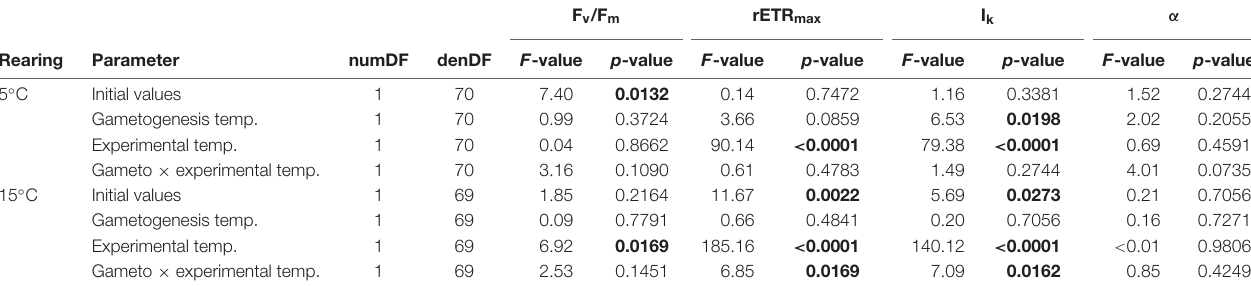
FIGURE 5 | Reaction norms of fluorometric parameters averaged over all five genetic lines of juvenile Laminaria digitata sporophytes in experiment 2. Primary x-axis: experimental temperature, secondary x-axis: rearing temperature, symbol colors: gametogenesis temperature. All plots show values obtained at the end of the 12-day experiment. (A) Optimum quantum yield F v /F m . (B) Maximum relative electron transport rate rETR max . (C) Saturation irradiance I k ( µ mol photons m − 2 s − 1 ). (D) Photosynthetic efficiency α (rETR/ µ mol photons m − 2 s − 1 ). Mean values ± SE over all genetic lines, n = 20. Statistical significance of the fixed factors gametogenesis temperature (Gam), experimental temperature (Exp), and their interaction (Gam × Exp) is summarized in the figure; *** p < 0.001; * p < 0.05; n.s., not significant. For full statistical report see Table 5 . TABLE 5 | Results of linear mixed effects models to examine thermal plasticity of fluorometric parameters of juvenile Laminaria digitata sporophytes in experiment